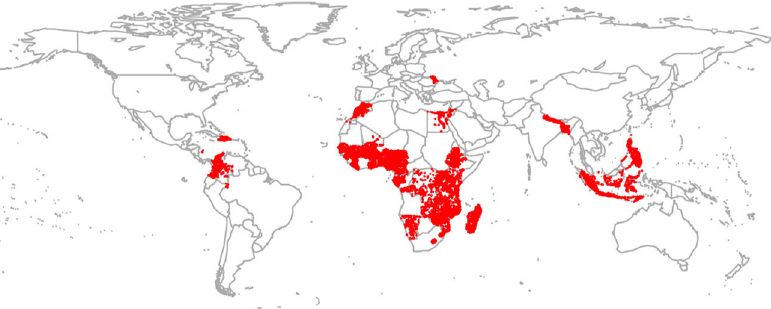
Fig. 1 Location of household clusters in the sample. Our health and environmental database covers 293,362 individuals in 35 countries (highlighted in red). The database links 2001 – 2012 geo-referenced Demographic and Health Survey ’ s (DHS) individual and household information with data on temperature, precipitation, and upstream watershed